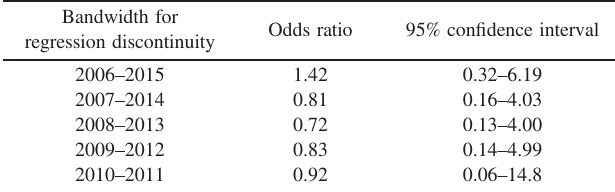
Table 3. Regression discontinuity analyses comparing the odds of clinically important traumatic brain injury being overlooked before vs after the Fukushima Daiichi Nuclear Power Plant